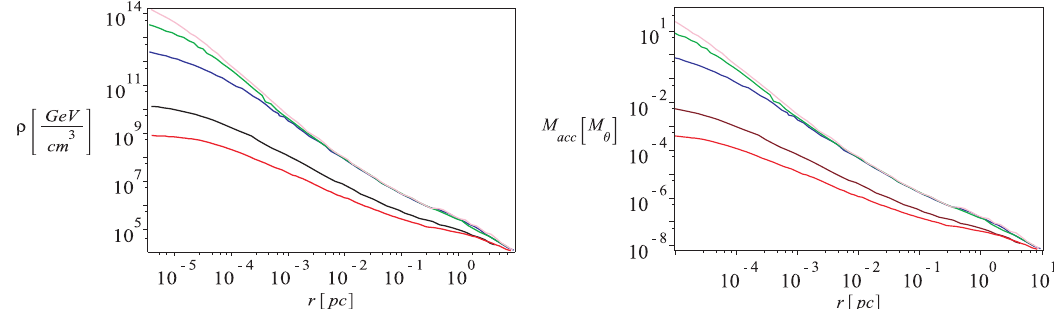
Figure 2. Left Panel : [74]’s density profiles. Right panel : accreted mass obtained from the density profiles in the left panel using Kouvaris formula. Pink line is the reproduction of the top line from Figure 1 of [74] (yellow line), while the green and blue line correspond to the central (green) and bottom (blue) lines in [74]. The black, and red lines belong to the same family but correspond to the less steep density profile.